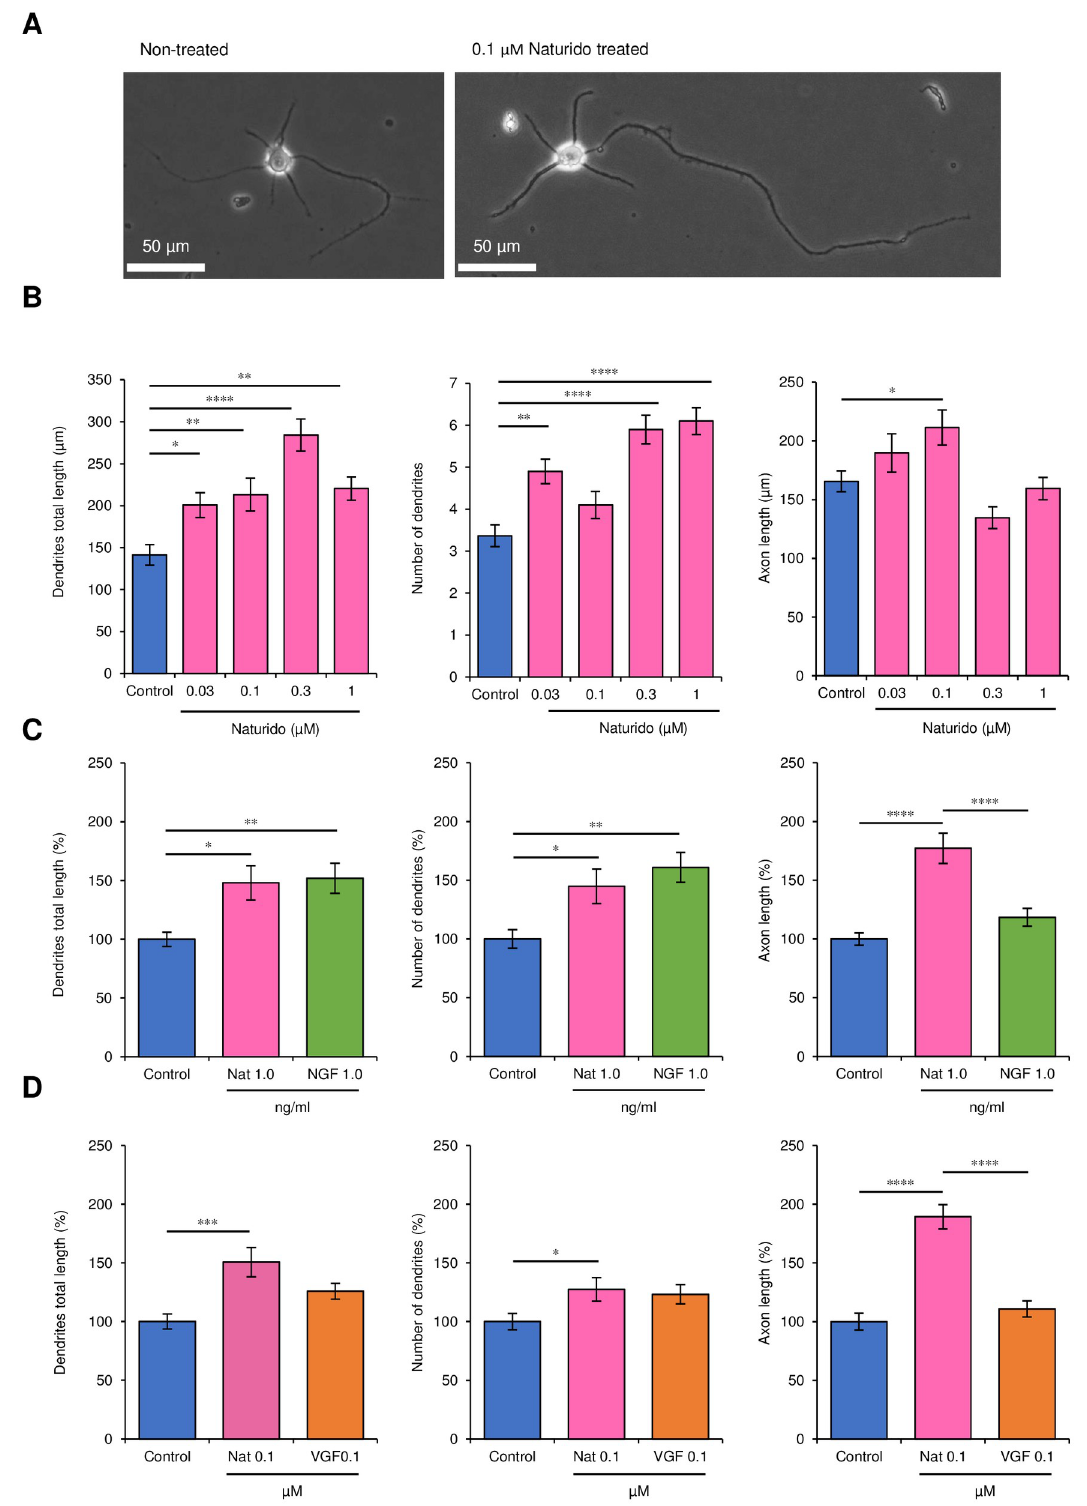
Fig 3. Effects of Naturido on dendrite and axon development in hippocampal neurons. (A) Representative photographs (left, non- treated; right, treated with 0.1 μ M Naturido; scale = 50 μ m); (B) Lengths of dendrites/neurons ( μ m, left), numbers of dendrites per neuron (middle), and lengths of axons/neurons ( μ m, right), as evaluated from 30 neurons after 3 days of the addition of Naturido at